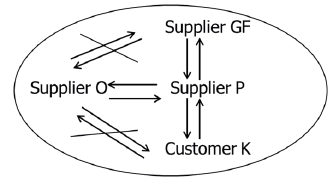
Fig. 2. – Customer K and its business network. Source: Authors.